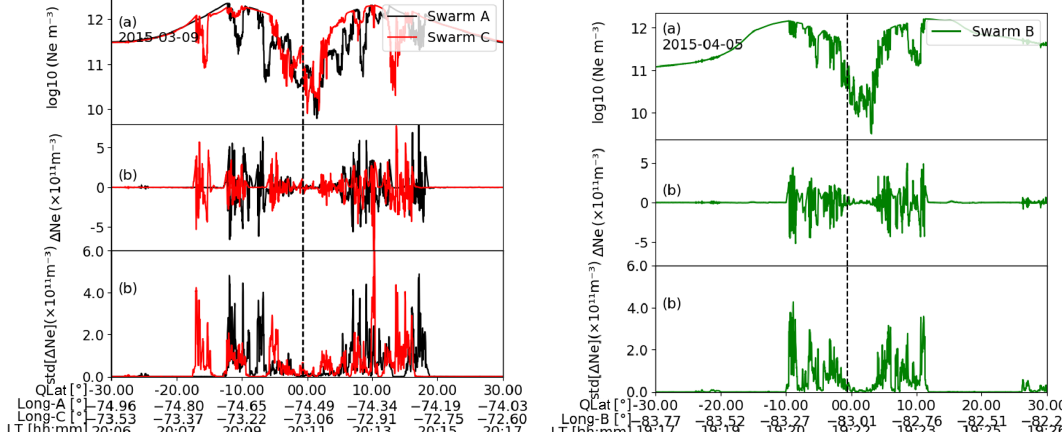
Figure 1. Swarm faceplate N e data of ionospheric irregularity events on 9 March and 5 April 2015. The panels show (a) the N e variation, (b) (cid:49)N e , and (c) std( (cid:49)N e ) as functions of QLat, longitude (Long), and local time (LT). The dashed vertical black line represents the approximate QLat of the JRO.